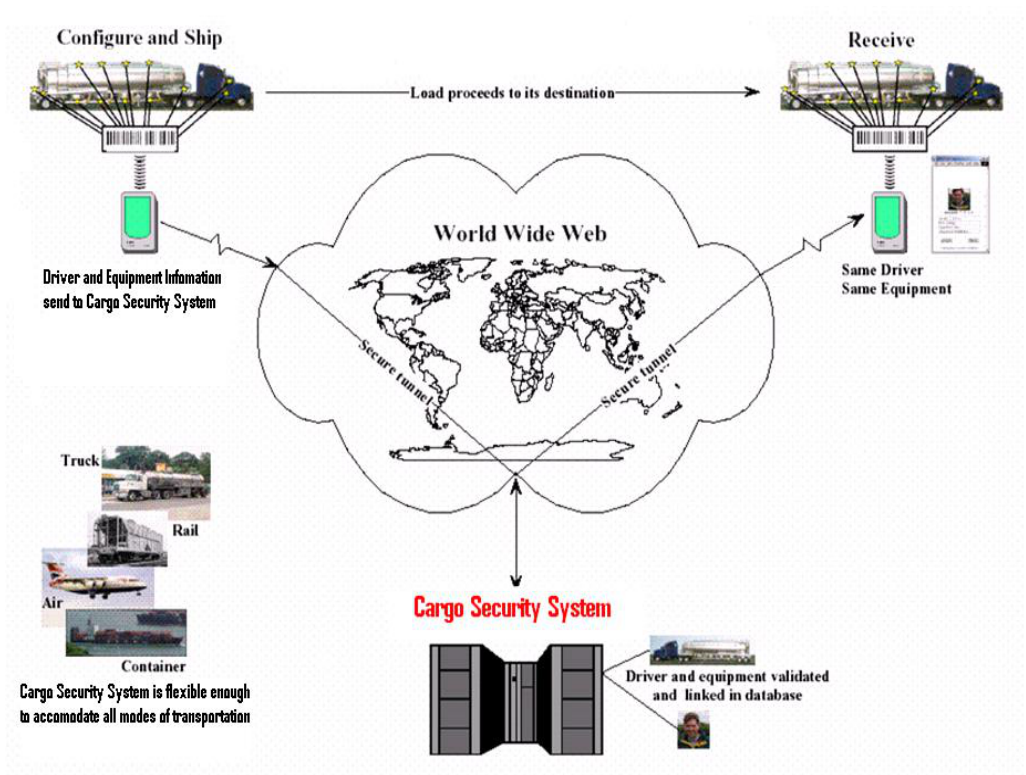
Figure 7. The system functionalities